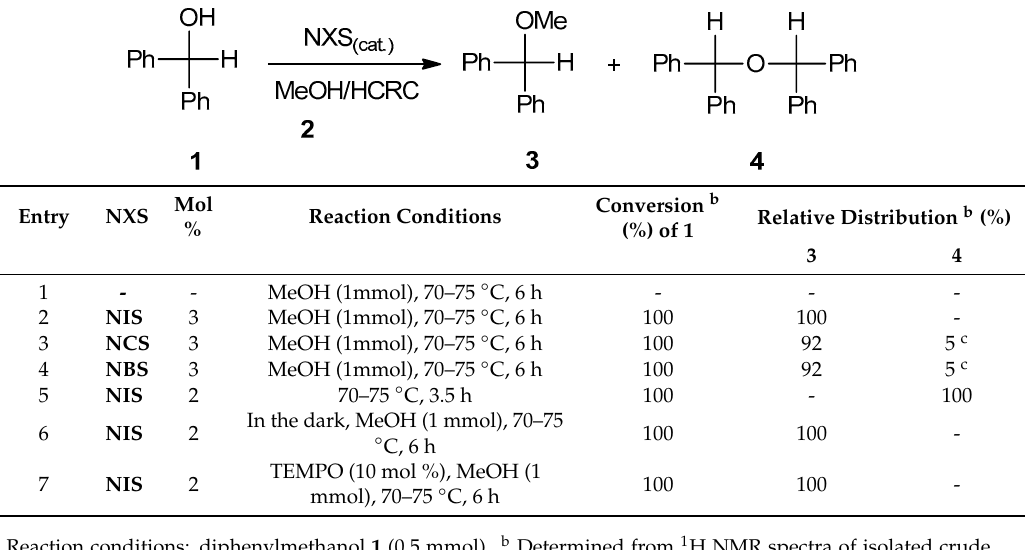
isolated crude reaction mixtures. c Benzophenone